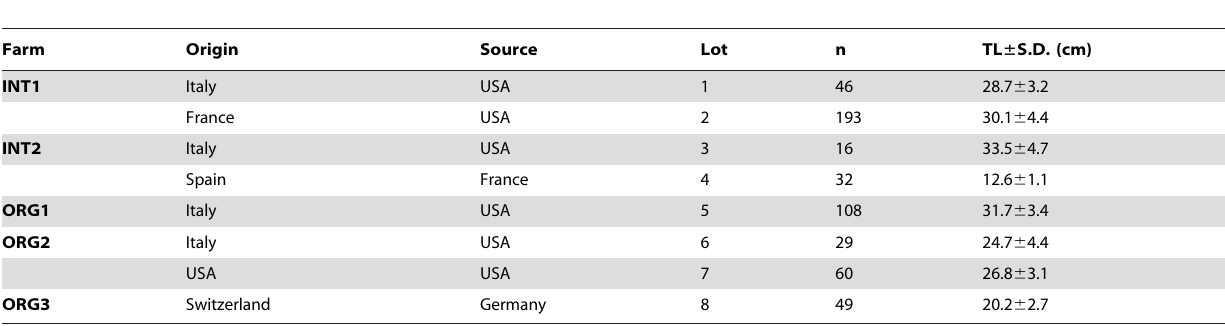
Table 2. Genetic origin ( Origin ), geographic origin of the source population ( source ), number ( n ) and total length (TL mean 6 standard deviation) of observed